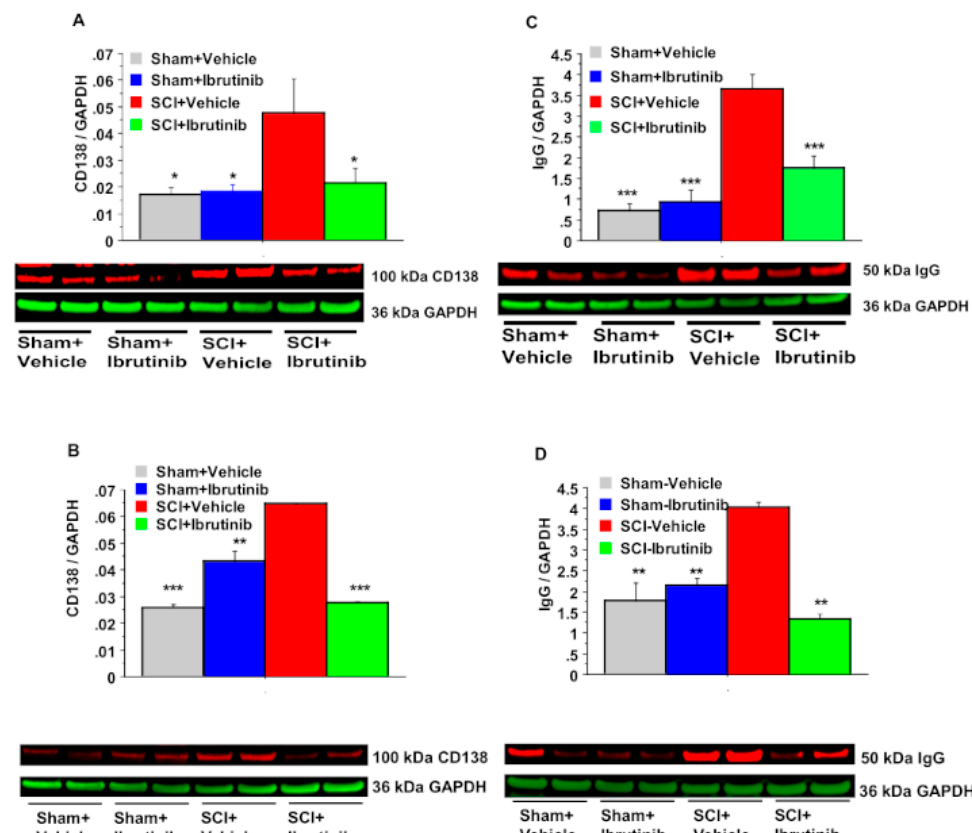
Figure 2. Effects of Ibrutinib post-treatment on levels of CD138 and total IgG. analyzed by quantification of Western blotting data. Western blot analysis of spinal cord samples (60 µg of protein extract each sample) at lesion epicenter showed that contusion injury increased CD138 ( A , B ) and total IgG ( C , D ) in the spinal cord 7 ( A , C ) and 14 ( B , D ) days post-injury compared with sham-operated animals. Ibrutinib treatment (6 mg/kg/day, starting at 3h post-injury for 7 days) resulted in reduced levels of CD138 ( A , B ) and total IgG ( C , D ) in the spinal cord lesion site at 7 ( A , C ) and 14 ( B , D ) days after contusive SCI compared with vehicle-treated animals. Quantification of CD138/GADPH and total IgG/GAPDH 7 and 14 days after contusive SCI was performed by the fold of blot density. Data are presented as mean ± S.E.M., n = 4 per group (7-day time point) or n = 2 per group (14-day time point), and analyzed with one-way ANOVA followed by Bonferroni post hoc analysis, * p < 0.05, ** p < 0.01, *** p < 0.001, compared to vehicle-treated SCI